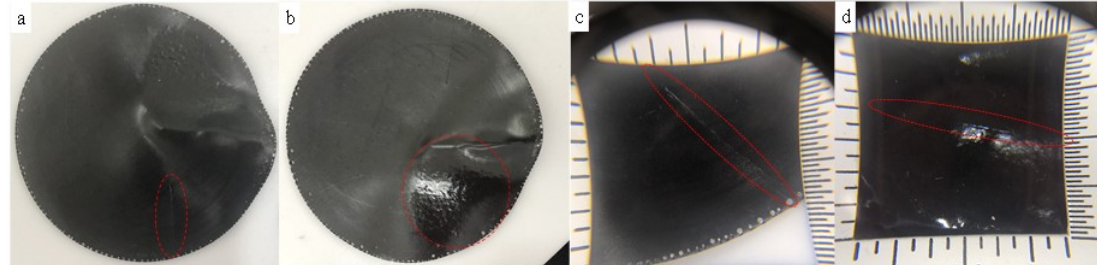
Figure 10. Photos ( a ) and ( b ) and photos in magnifying glass ( c ) and ( d ) of the composite film before (a) and (c) and after (b) and (d) healed using IR light.